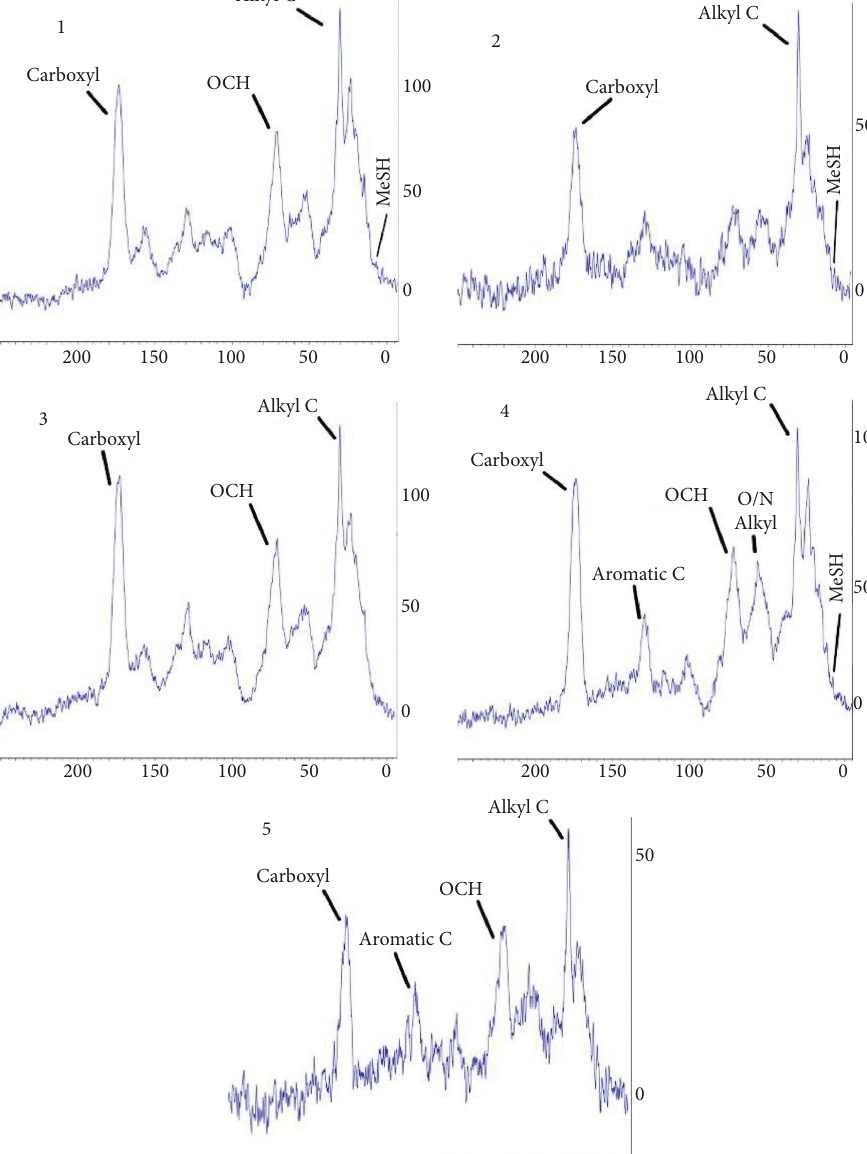
Figure 3: CP/MAS 13 C NMR spectra of the HAs from Livingston Island,